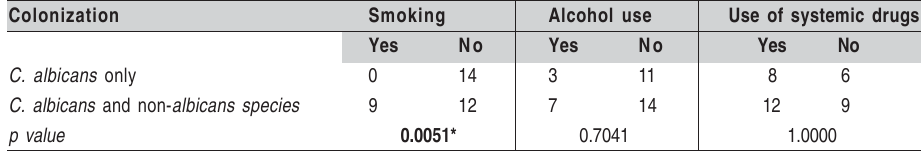
Table 1 - Distribution of primary colonization of Candida species in patients with Denture stomatitis.